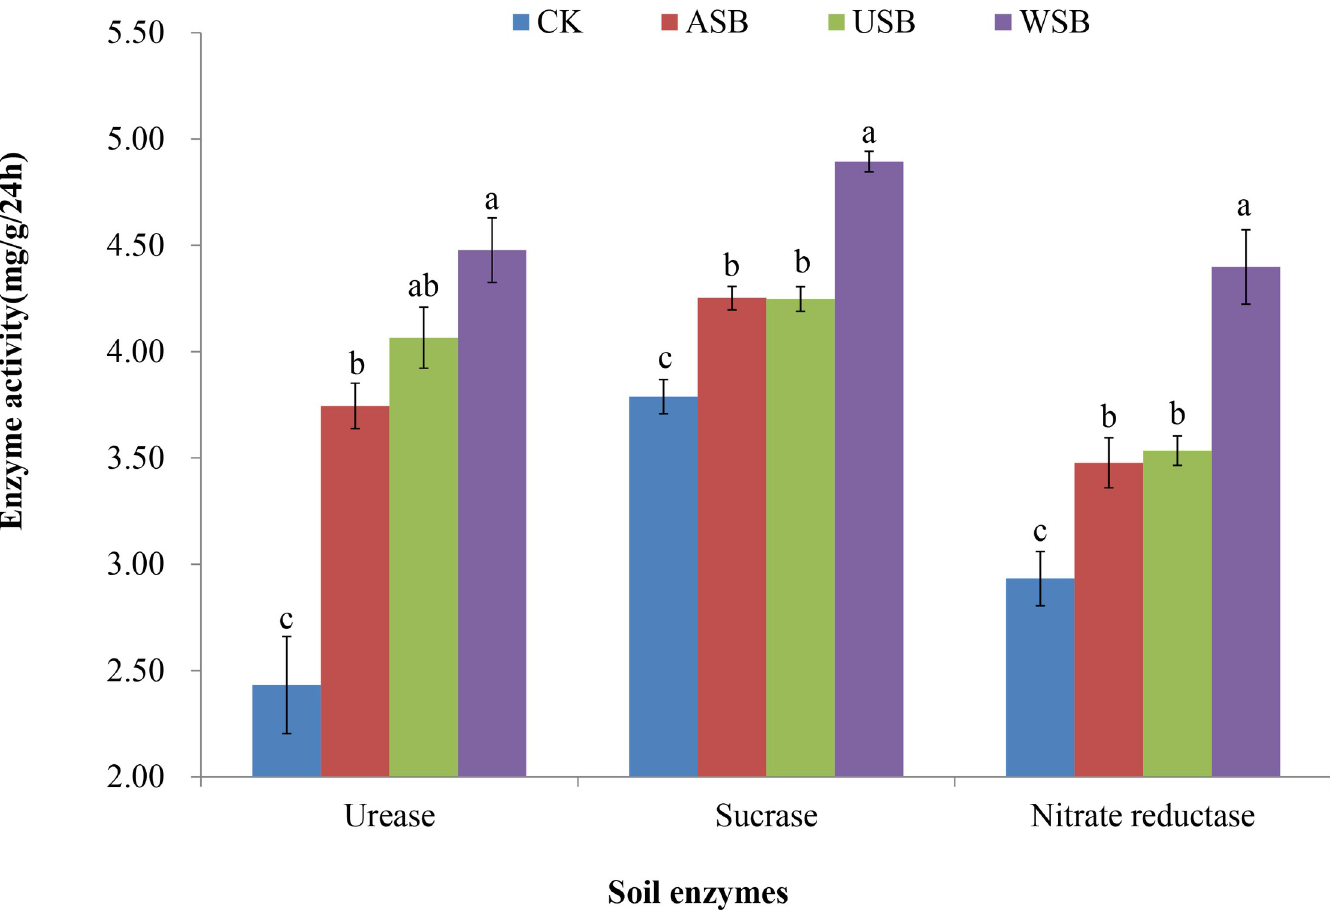
Fig 3. Activities of enzymes in soils treated with consecutive soybean planting and covering. Activities of the enzymes were measure at the conclusion of the third application of the treatments. Bars represent mean ± standard error. Different lowercase letters indicate significant differences among treatments (P < 0.05). CK, control; ASB, aboveground soybean parts; USB, underground soybean parts; WSB, whole soybean plants.